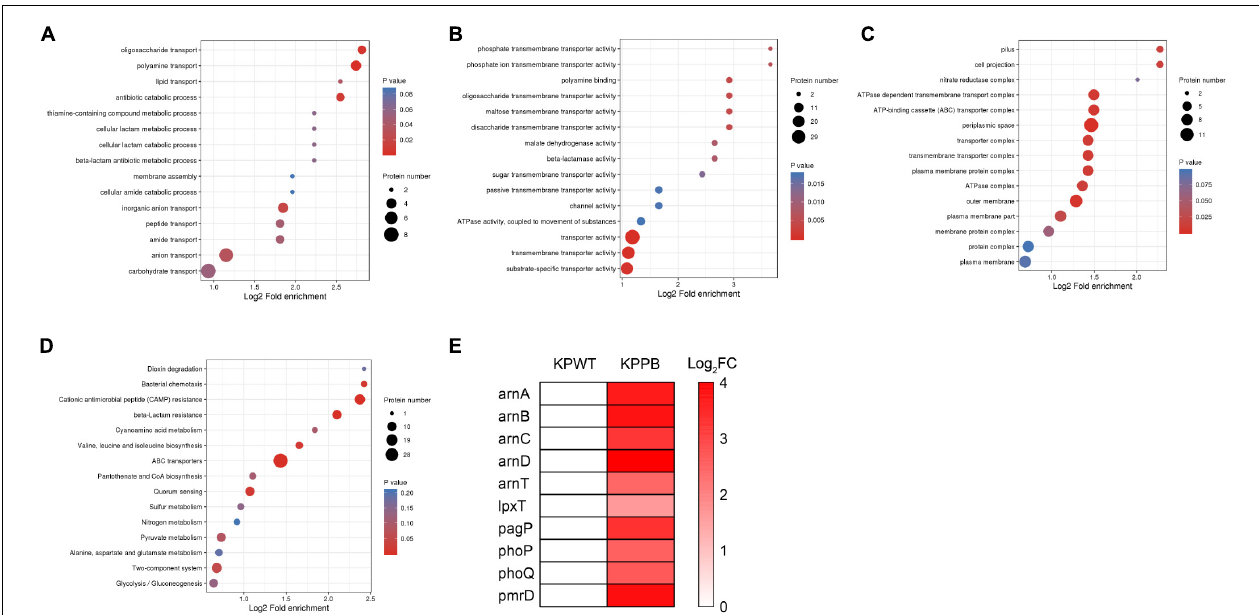
FIGURE 3 | Enrichment analysis of the differentially expressed proteins (DEPs) between polymyxin B (PB) resistant and susceptible Klebsiella pneumoniae . GO functional enrichment analysis of biological process (A) , molecular function (B), and cellular component (C) . (D) KEGG enrichment plot demonstrated the top 15 pathways of the DEPs. (E) Expression pattern of the DEPs associated with LPS